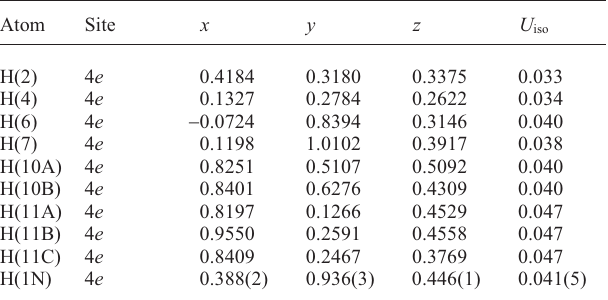
nearly planar molecule is in good agreement with the structure of methyl 5-chloro-1 H -indole-2-carboxylate [15]. An examination of the deviations from the least-squares planesthrough individual rings shows that rings A (N1/C1/C2/C3/C8) and B (C3-C8) are each planar. The indole ring system is planar, with a puckering amplitude Q =0.0069Å[16].Themeanplaneofthemethoxycar- bonyl group is s slightly twisted with a dihedral angle of 2.06(15)° with respect to the indole ring system. Intermolecular N–H···O hydrogen bonds between C=O and N1–H1N link the molecules, forming centrosymmetric dimers. Table 2. Atomic coordinates and displacement parameters (in Å 2 )